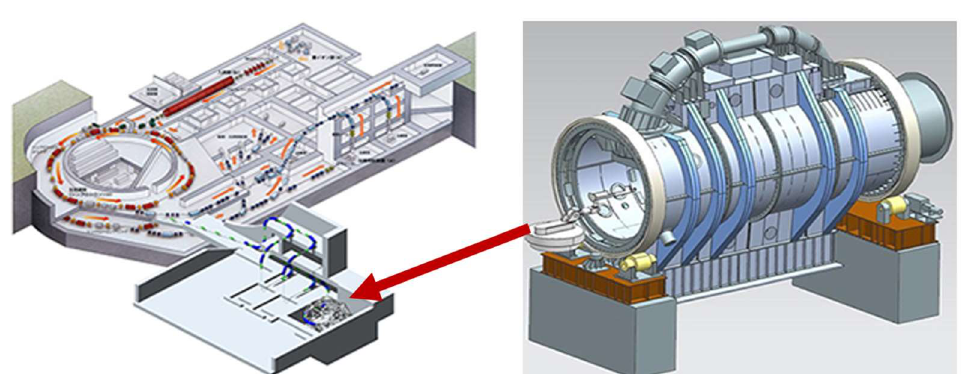
Fig. 1. Left: The Heavy-Ion Medical Accelerator in the Chiba (HIMAC) complex consists of three ion sources, one linear accelerator, two synchrotron rings, and three treatment rooms. The new treatment facility also has three treatment rooms. Right: A three- dimensional image of the iso-centric rotating gantry under development for the new treatment facility.